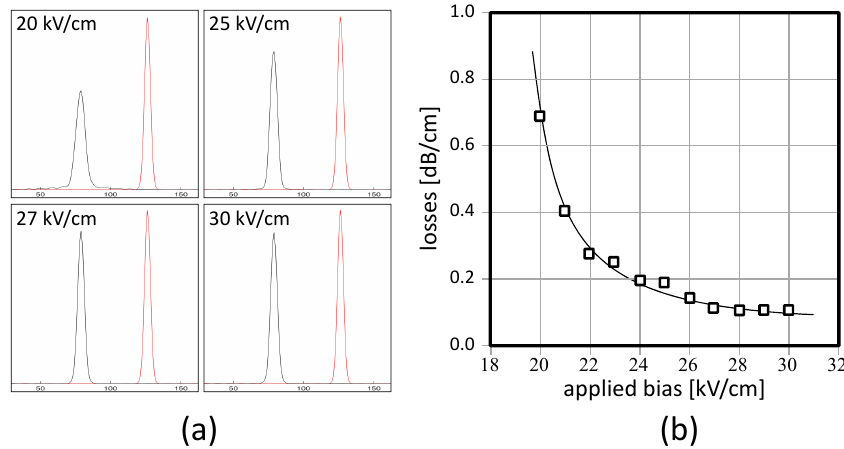
Figure 6. ( a ) Input (red) and output (black) profiles of the signal beam for different applied biases; ( b ) propagation losses of solitonic waveguides for different applied biases.